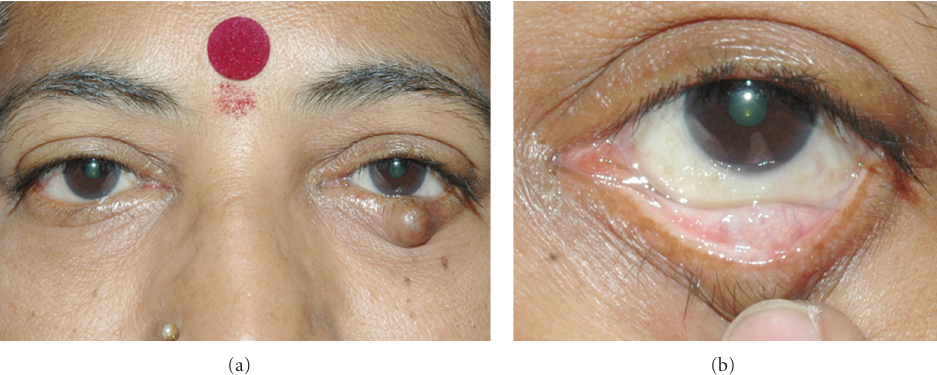
Figure 1: Figures 1(a) and 1(b) Showing a nodular mass measuring 10 × 10 × 8 mm in the lower eyelid with smooth surface. On eversion of the eyelid there was an area of scarring in the tarsal conjunctiva.